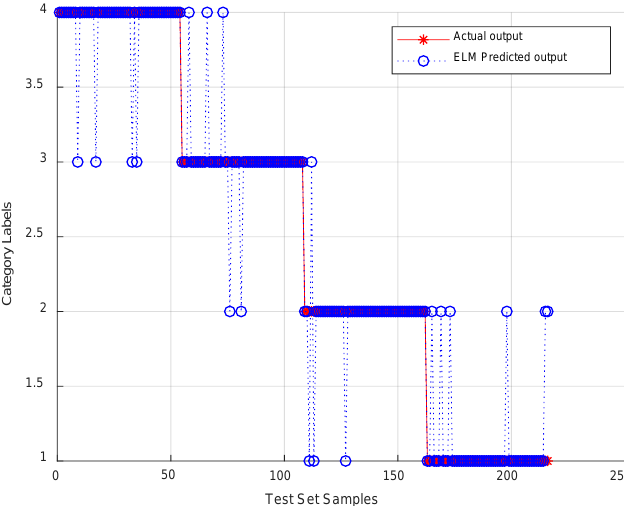
Figure 12. ELM (200 nodes)-based fatigue state detection results.